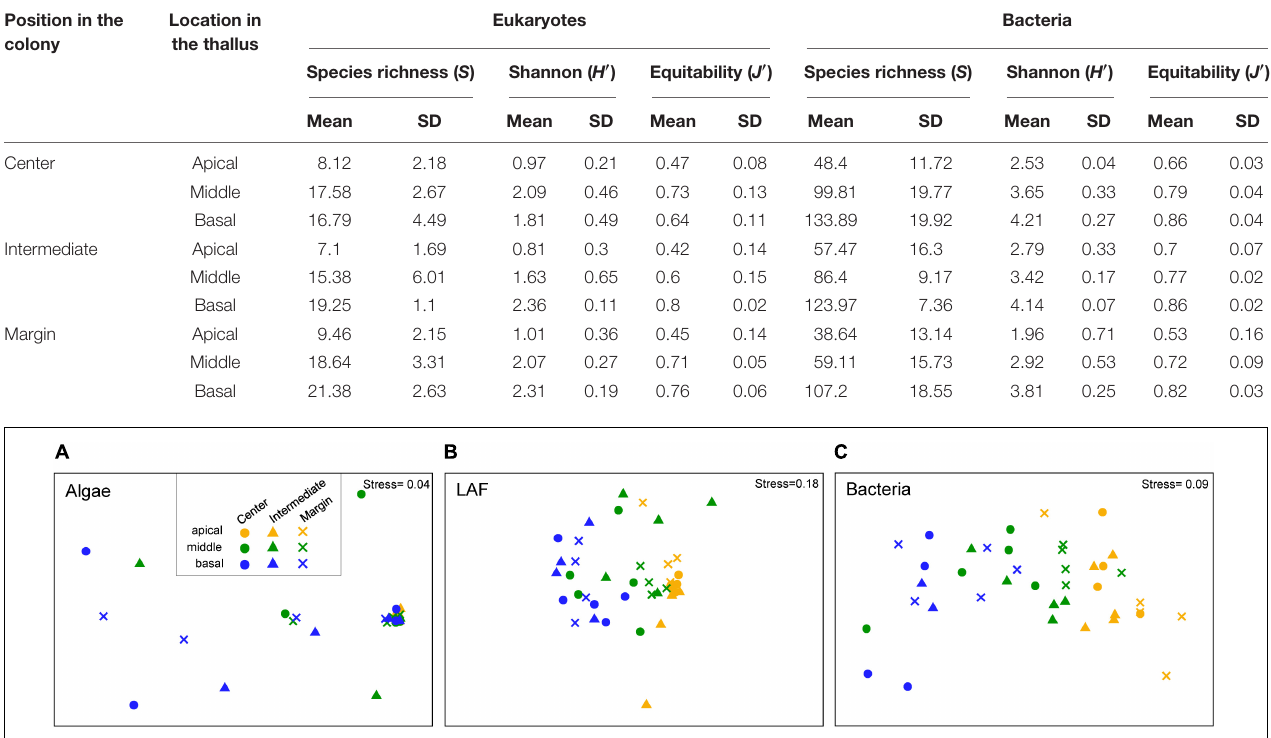
FIGURE 6 | Non-metric multidimensional scaling (NMDS) analysis of microbial community composition based on the OTU composition of algae (A) , lichen-associated fungi (LAF) (B) , and bacteria (C) . Three to five samples with more than thousand sequence reads were included in each group. Standardized OTU abundance matrices were used to calculate Bray–Curtis similarities between